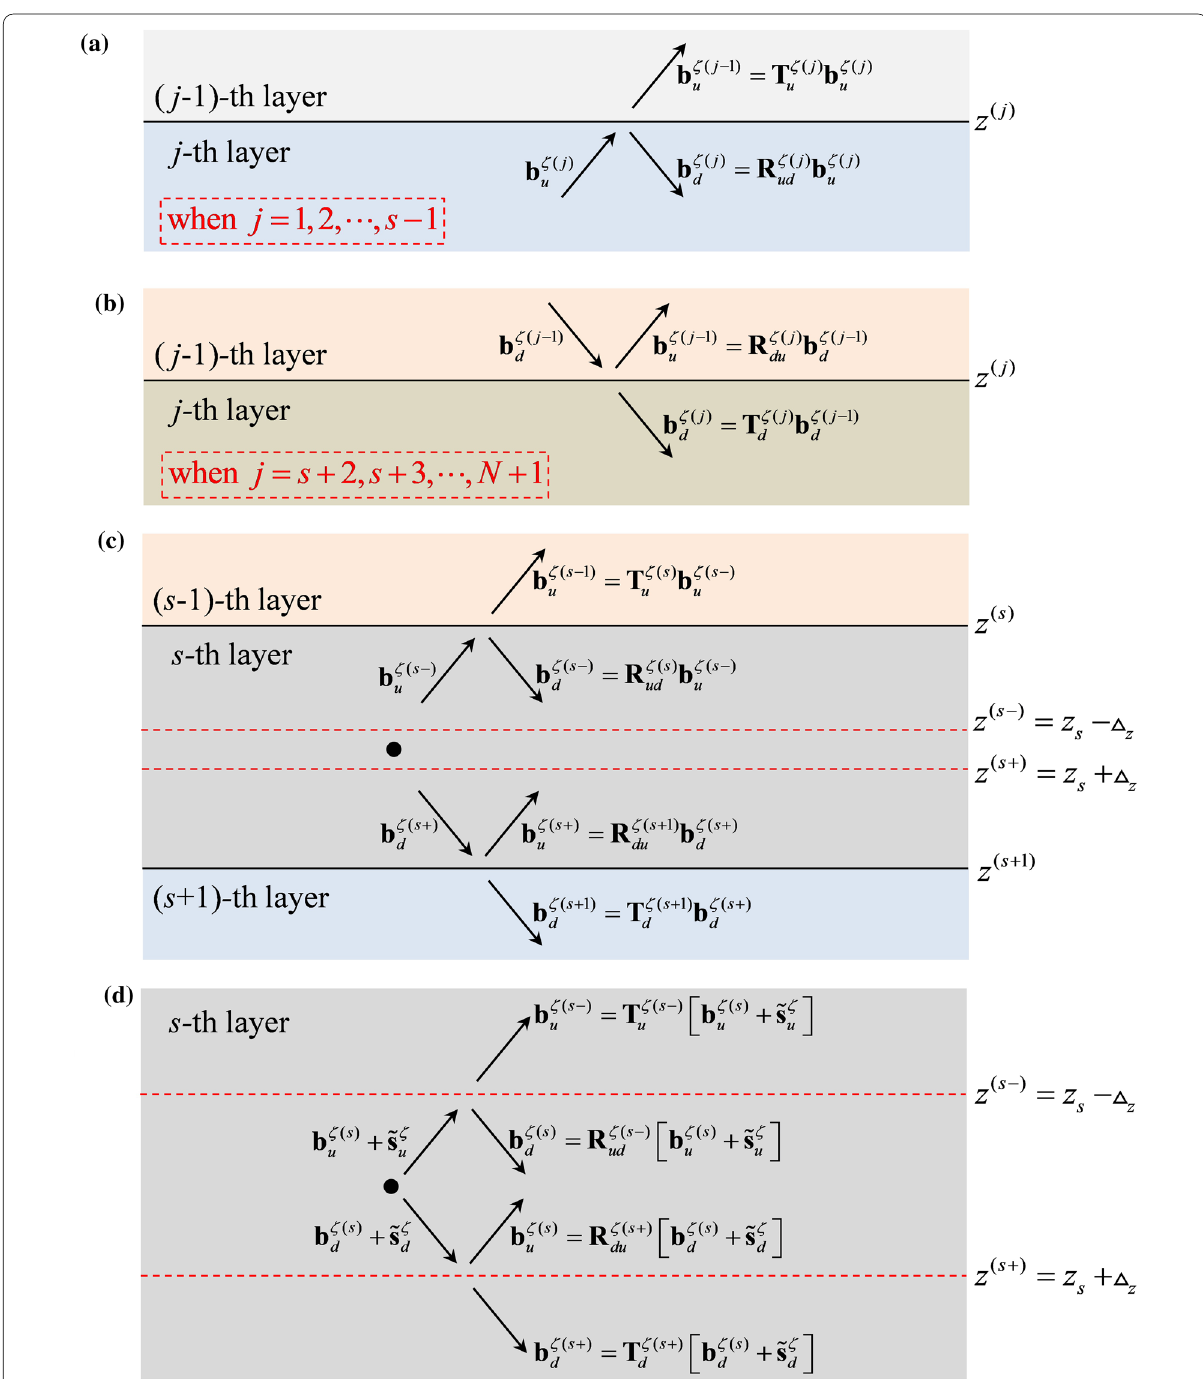
Fig. 2 Schematic diagram of the LAC GRT coefficients defined for different interfaces. a – c Coefficients defined for the real interfaces z z ( 1 ) , z ( 2 ) , , z ( N ) , while ( d ) accounts for those defined for the two artificial interfaces z = · · ·